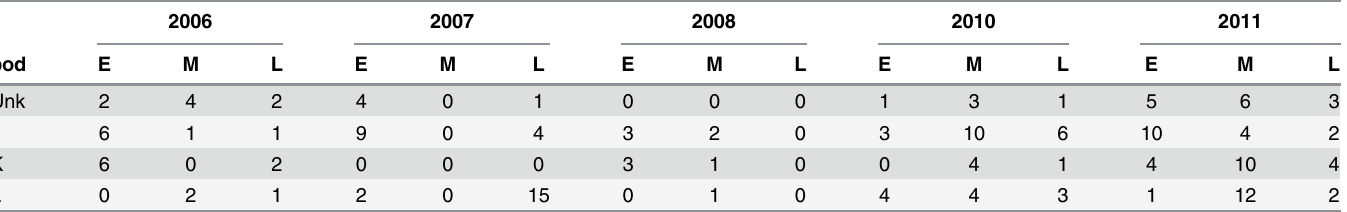
Table 5. Summary of pod origins of fecal samples. Each year/season (E = early; M = middle; and L = late summer, respectively) combination was one sample pool, with the exception of mid-summer 2007 and late summer 2008 for which there were no samples in the